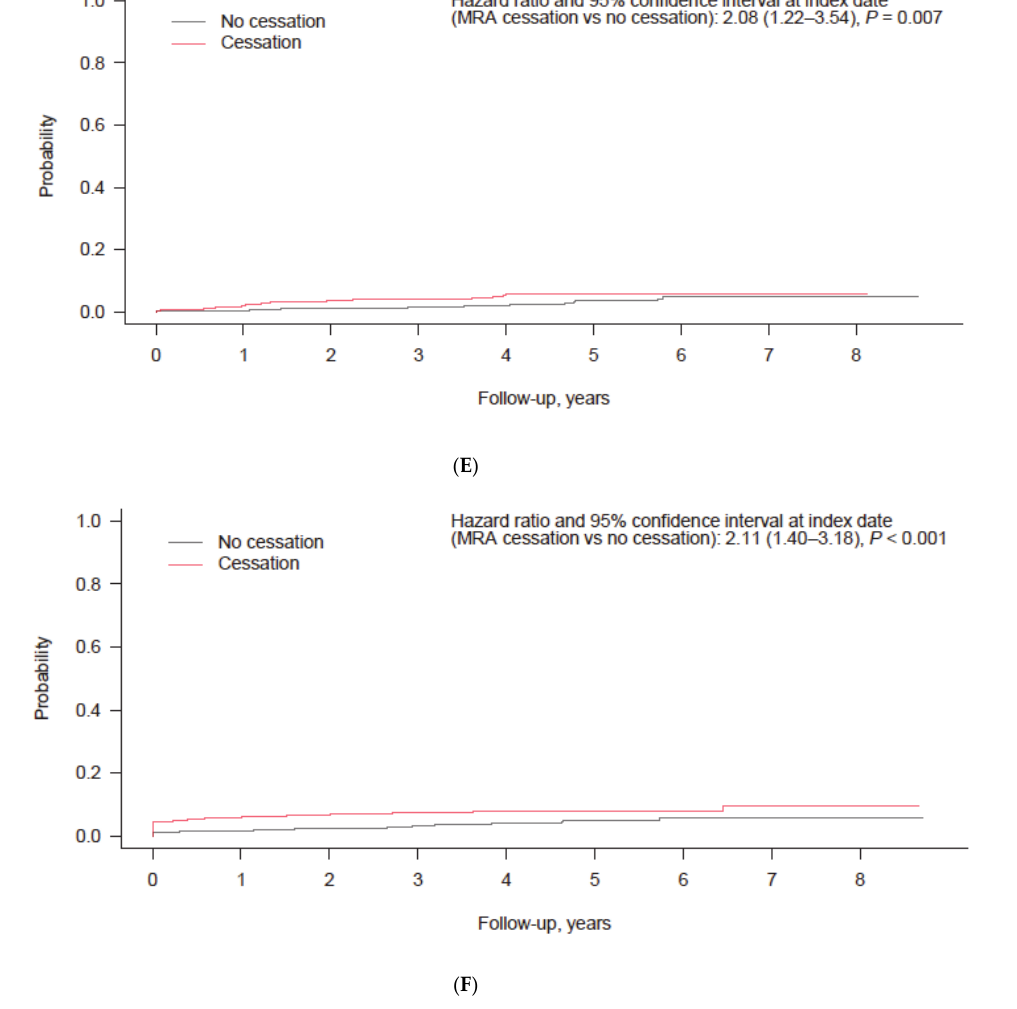
Figure 5. Cumulative incidence of clinical outcomes according to treatment cessation and non- cessation in propensity score-matched patients receiving MRA therapy (cumulative incidence function analysis). ( A ) In-hospital death; ( B ) emergency room visit; ( C ) hospitalization; ( D ) hospitalization due to heart failure; ( E ) renal replacement therapy; ( F ) hospitalization for MI, arrhythmia, or cardiac arrest. Abbreviation: MI, myocardial infarction; MRA, mineralocorticoid receptor antagonist